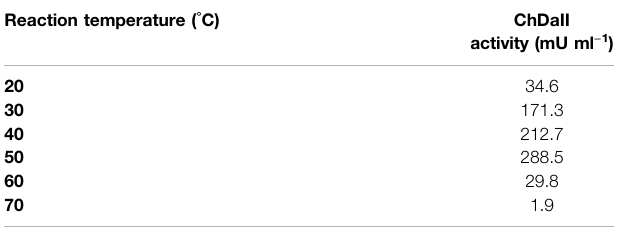
TABLE 1 | Effect of reaction temperature on the activity of recombinant chitin deacetylase ChDaII from Mucor circinelloides IBT-83. The culture medium obtained after 48 h of cultivation of the selected transformant was used as the enzyme preparation.